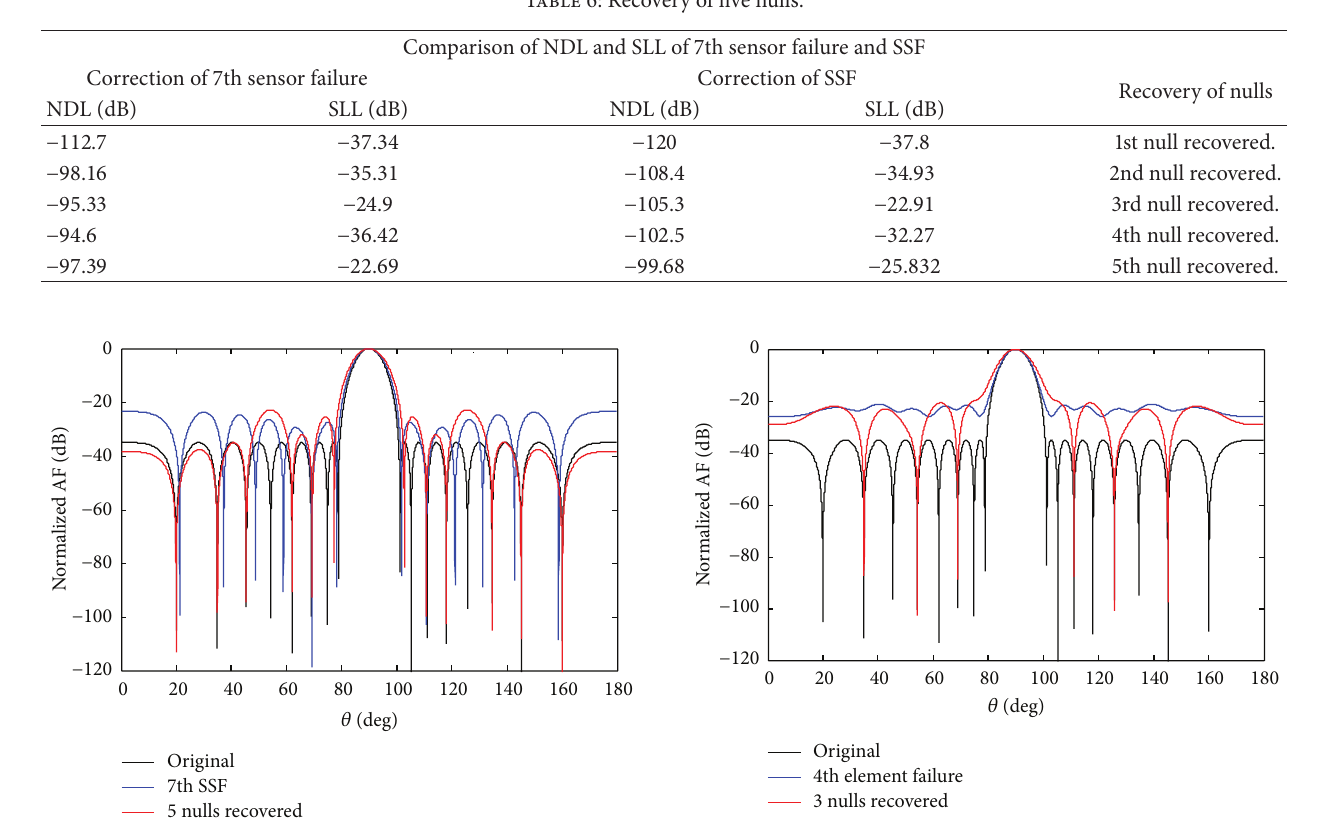
Table 6: Recovery of five nulls.